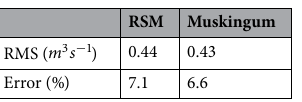
Table 4. Simulation results for the Arrat’s reach.